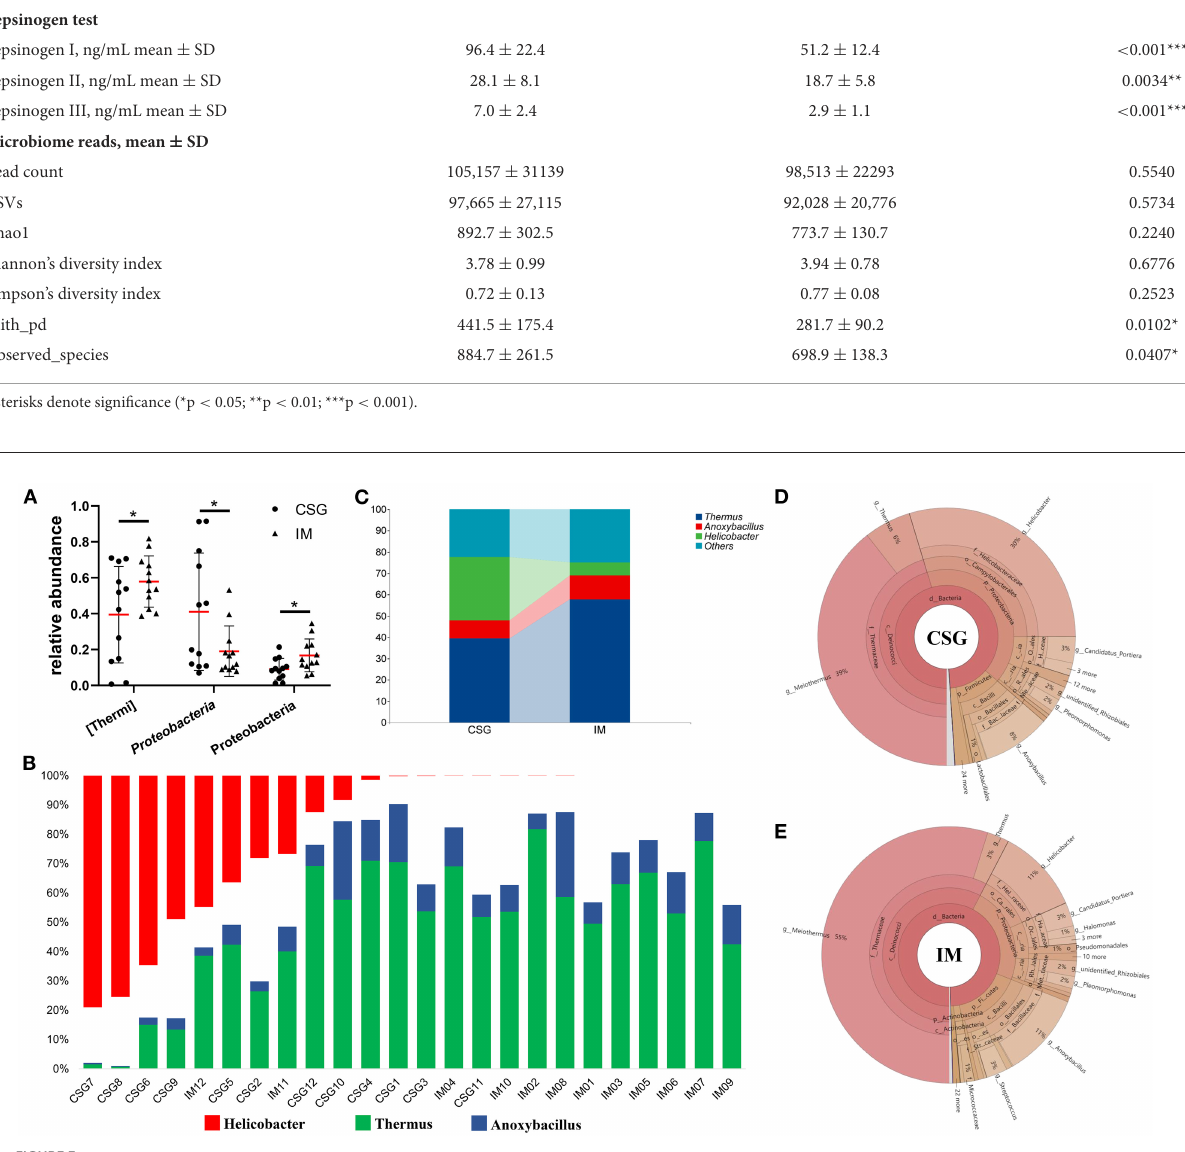
FIGURE3 Differences in microbiota composition of gastric juices between CSG and IM patients. (A) Composition difference of gastric juices microbiota at the phylum level between CSG and IM patients. (B) Composition difference of gastric juices microbiota at the genus level between CSG and IM patients. (C) An integrated representation of the differences in the composition of gastric microbiota between CSG and IM patients at the genus level. (D,E) Krona species composition of gastric juices microbiota in patients with CSG and IM. Asterisks denote significance (* p <